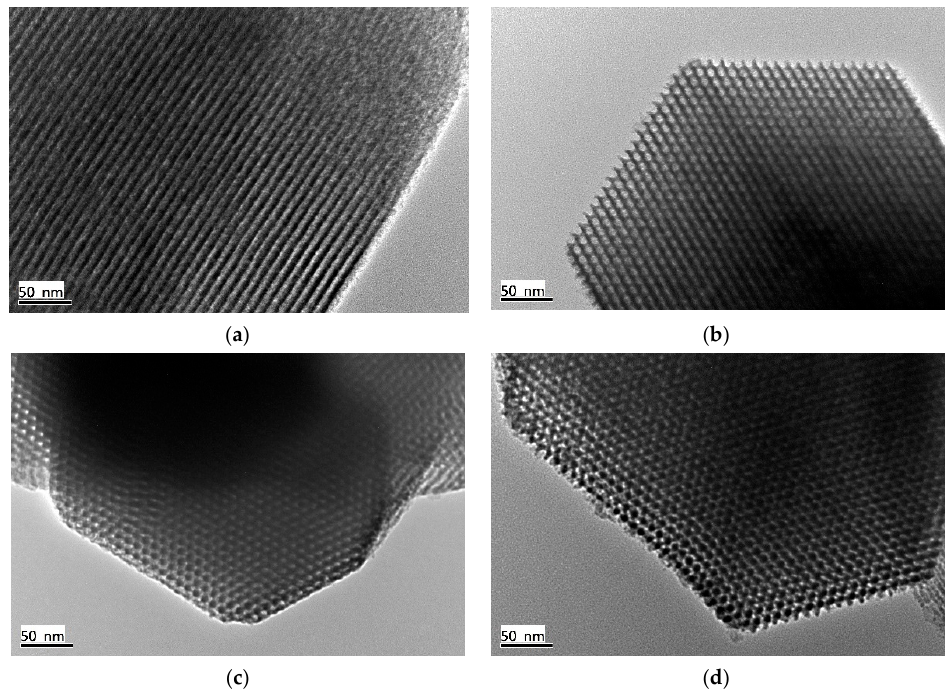
Figure 7. TEM images: ( a , b ) SBA ‐ 15; ( c ) SBA ‐ 15/APTES; ( d ) SBA ‐ 15/PEHA.